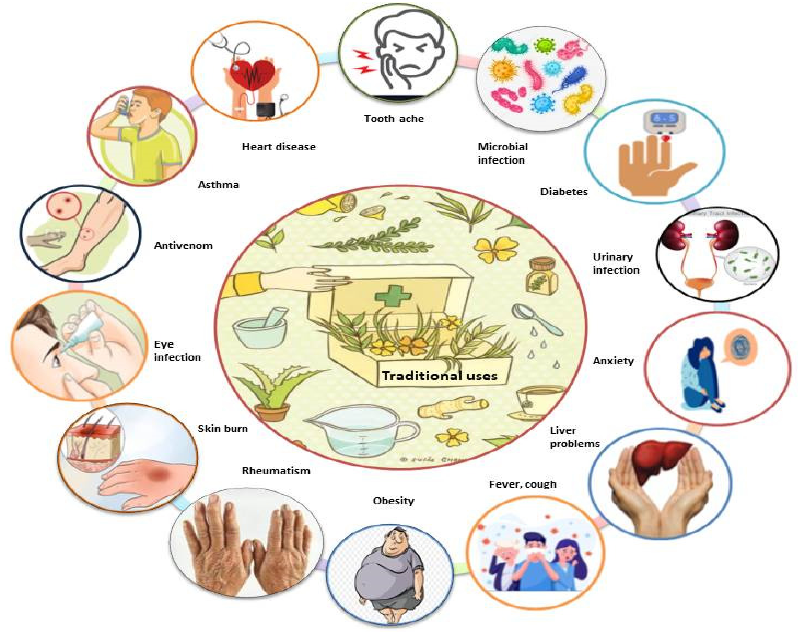
Figure 3. Schematic illustration of the traditional uses of the genus Mimosa. Table 1. Ethnotraditional uses of different species of the genus Mimosa.